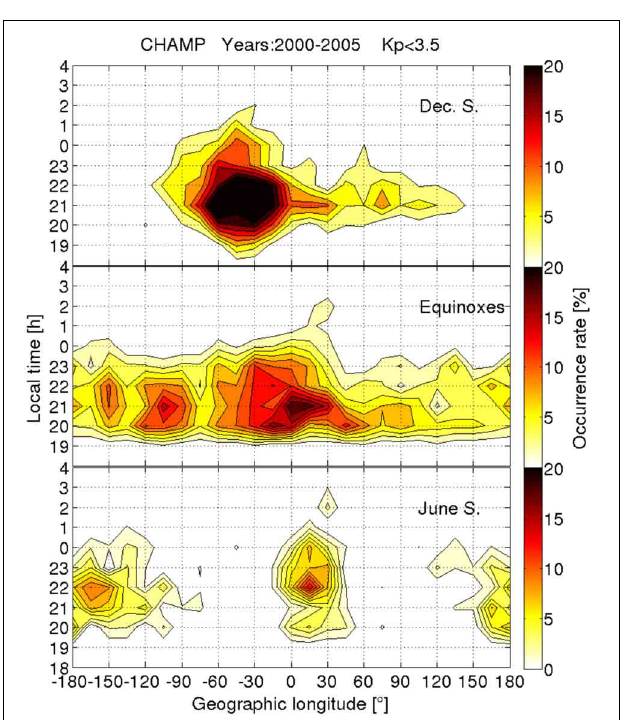
FIGURE 3 | Longitudinal variation of the local time dependence of plasma fine structures separately for the three Lloyd